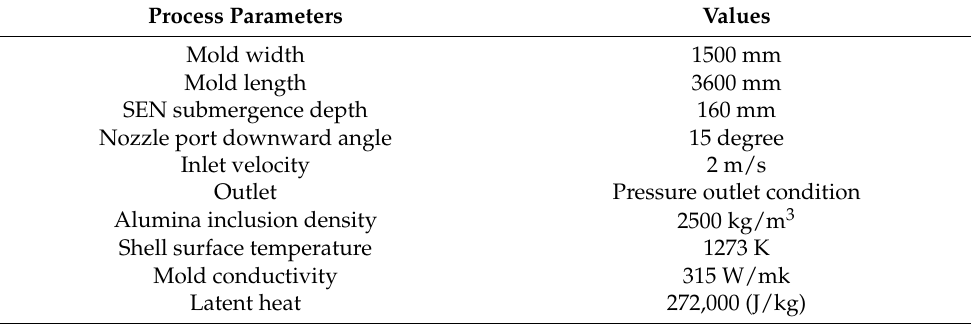
Table 3. Process